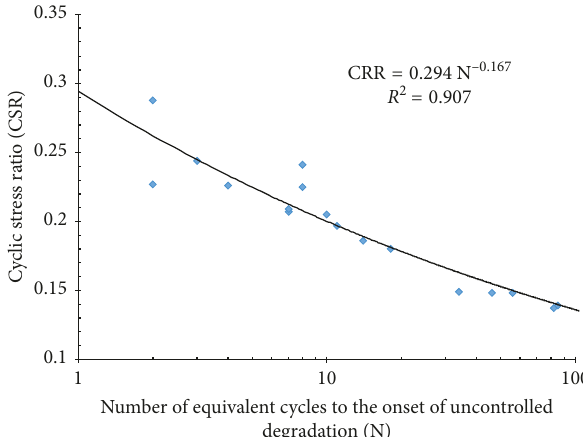
Figure 1: The cyclic resistance, to the onset of uncontrolled degradation, of a loose to medium dense nonplastic Rhode Island silt ( after